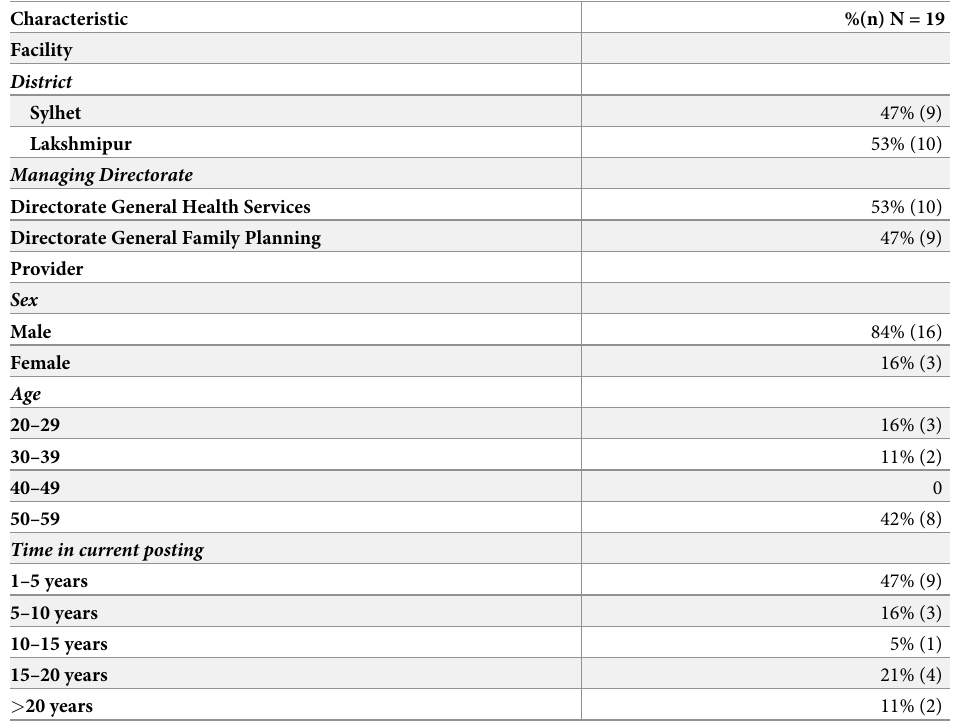
Table 2. Characteristics of the primary health facilities and providers in